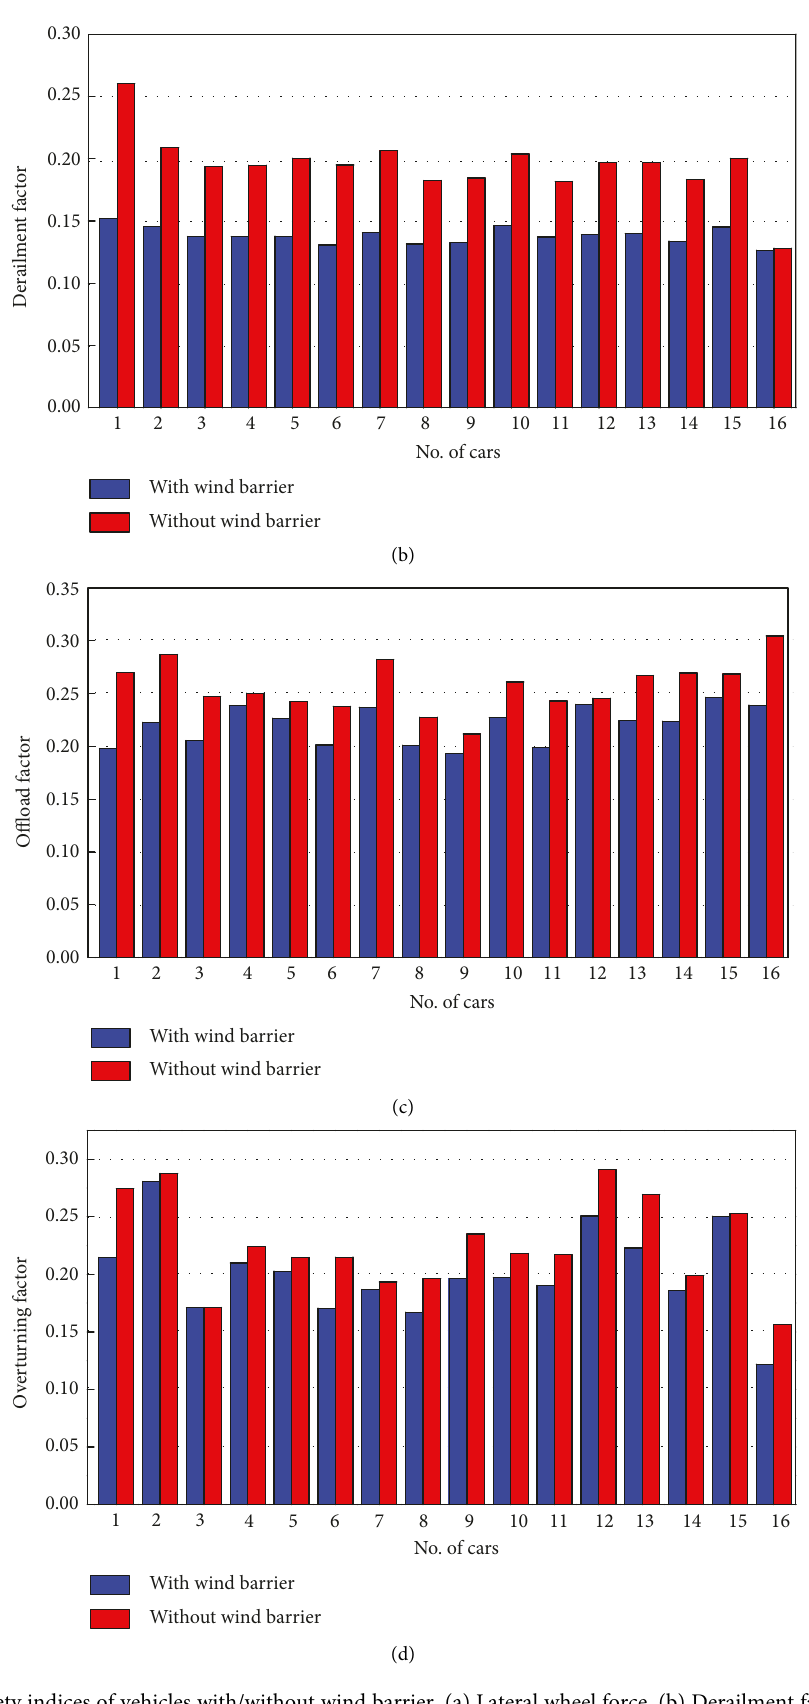
Figure 12: Running safety indices of vehicles with/without wind barrier. (a) Lateral wheel force. (b) Derailment factor. (c) Offload factor. (d) Overturning